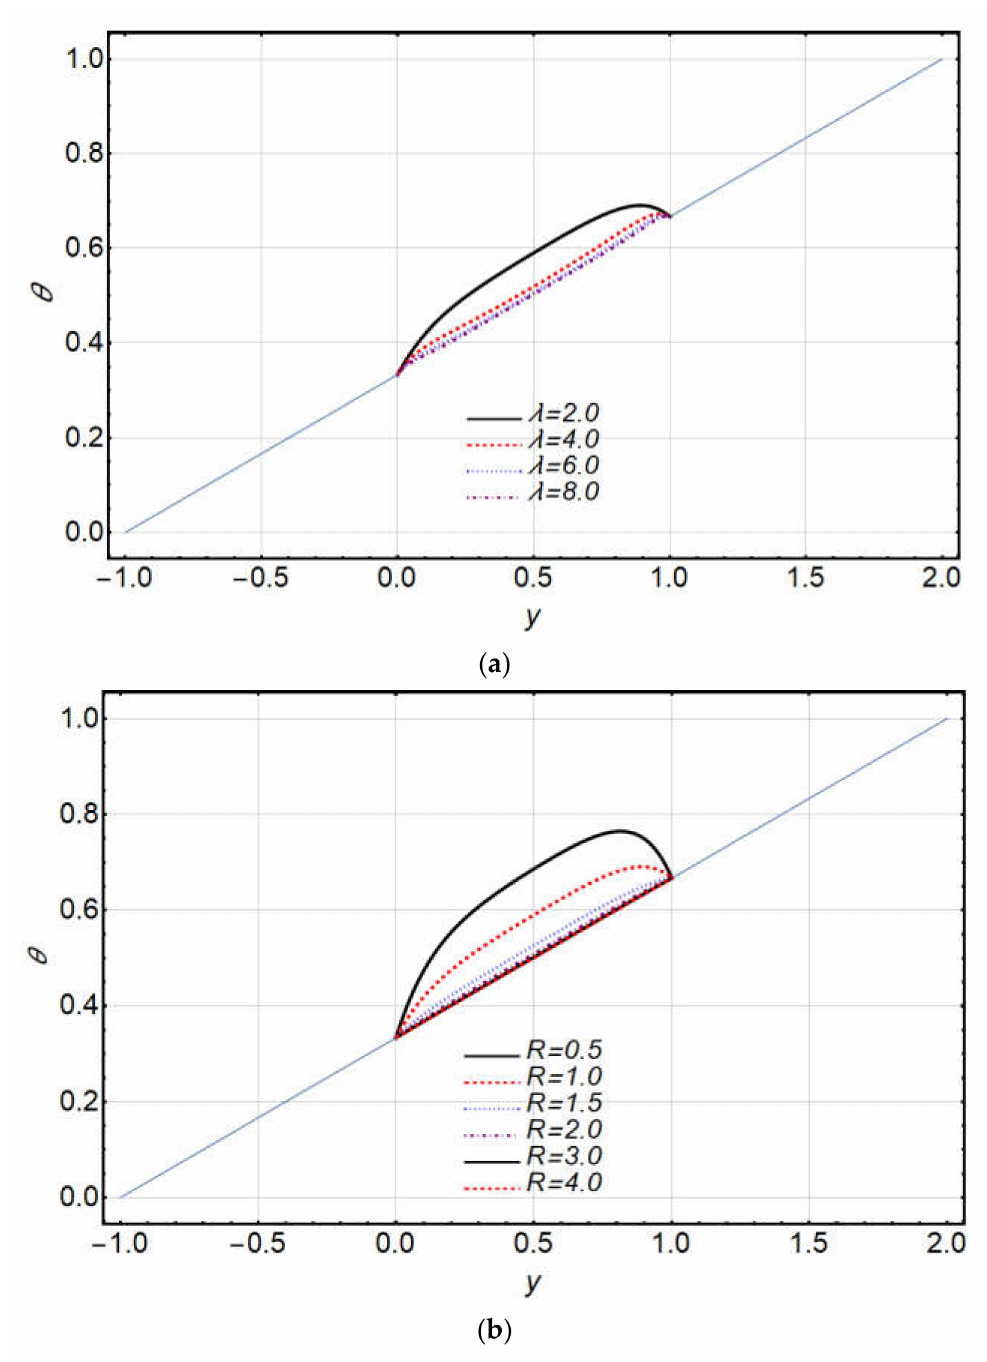
Figure 11. Temperature distribution against ( a ) λ , ( b ) R